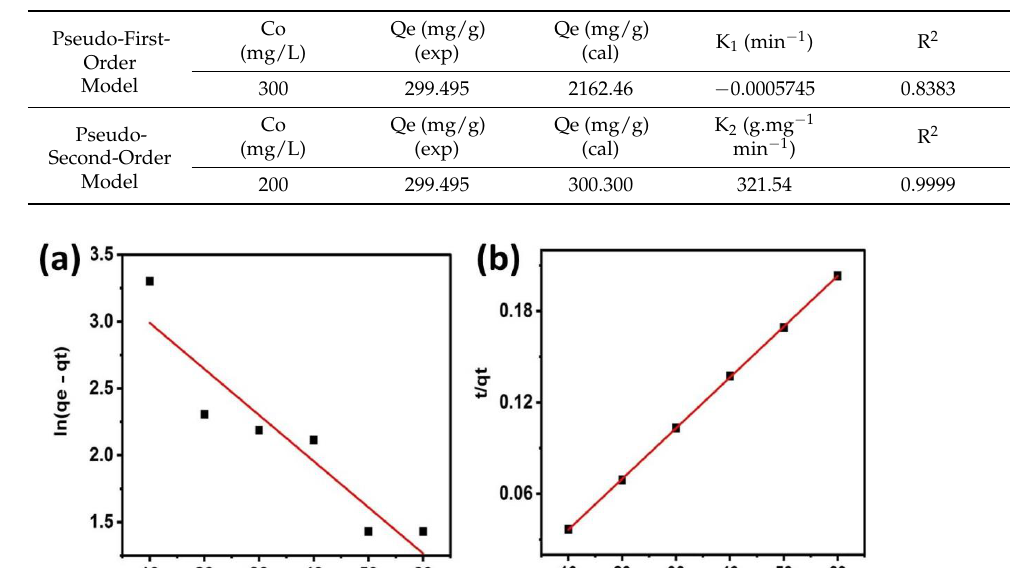
Figure 7. Plot of pseudo-first-order ( a ) and plot of pseudo-second-order ( b ).